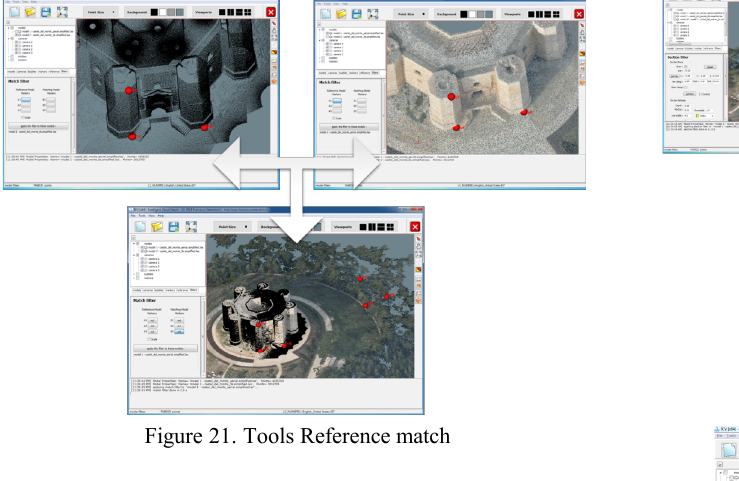
Figure 21. Tools Reference match